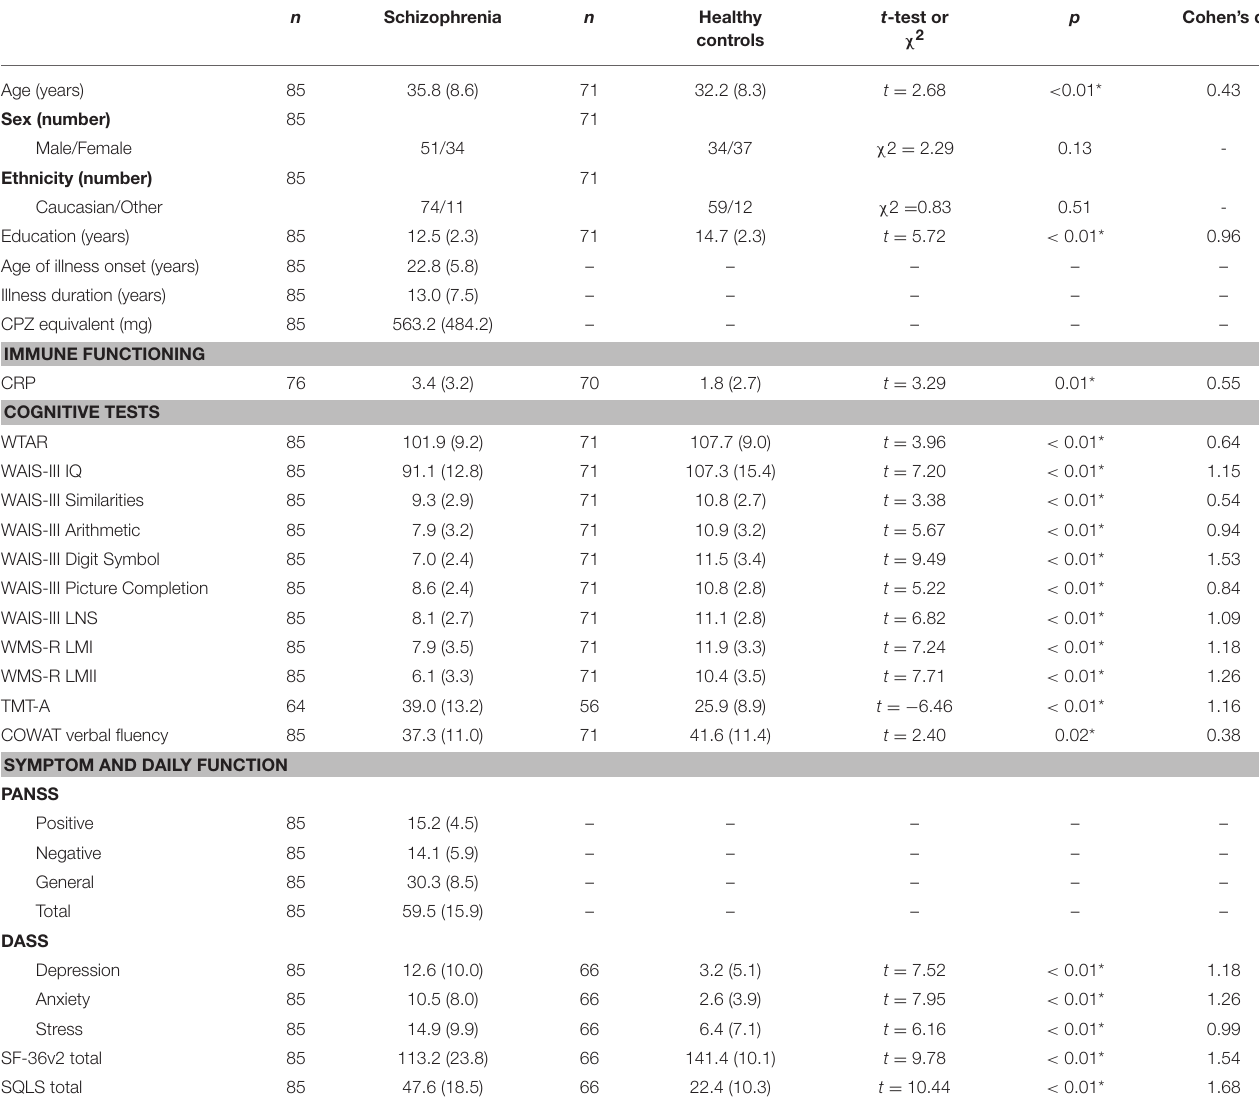
TABLE 7 | Demographics, cognitive, symptom severity, negative emotional states, daily function measures, and C-reactive protein levels in chronically ill patients with schizophrenia and healthy controls. n